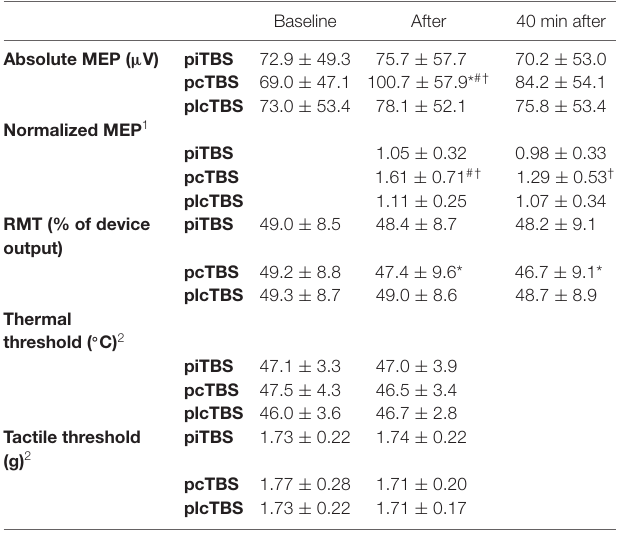
TABLE 1 | Cortical excitability (absolute and normalized MEP amplitude, and RMT), thermal thresholds and tactile thresholds after prolonged theta burst stimulation